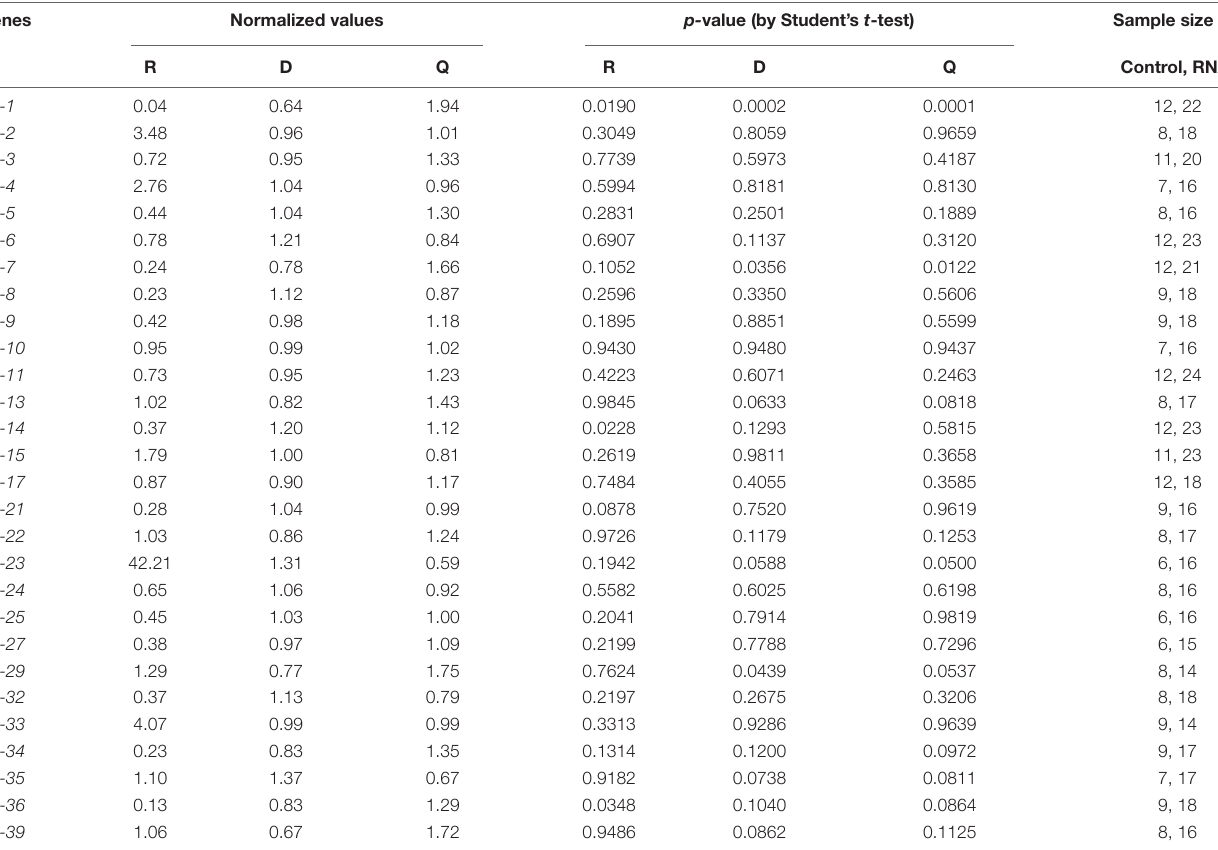
TABLE 3 | Normalized values of each state of roaming, dwelling and quiescence, the sample size, and statistical significance of 28 ins genes. Genes Normalized values p- value (by Student’s t -test) Sample size ( N )